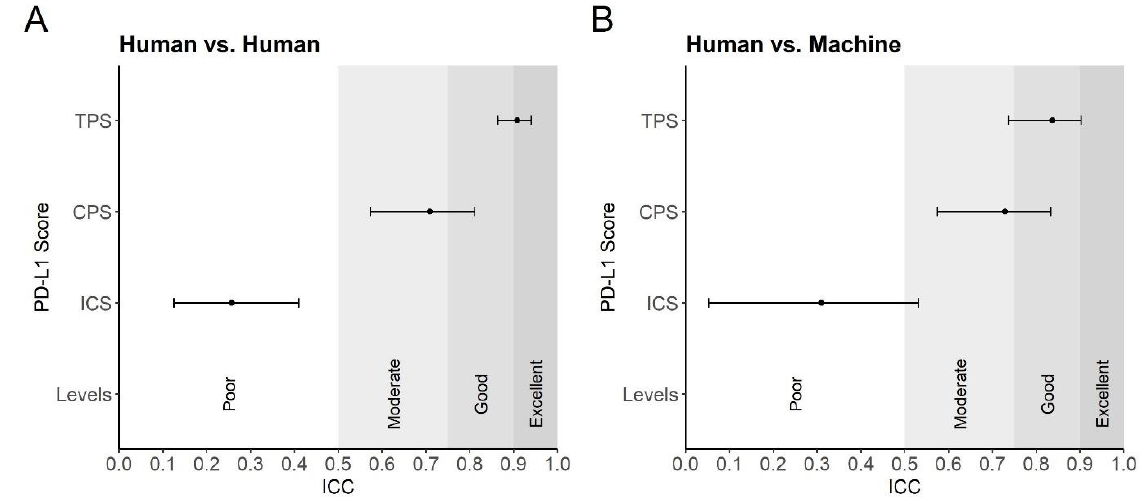
Figure 4. Intraclass correlation coefficient for PD-L1 scores. ( A , B ) The interclass correlation coefficients (ICCs) for TPS, CPS and ICS. The ICC is shown on the x -axis. An ICC of 0 to 0.5 is rated as poor, 0.5 to 0.75 is rated as moderate, 0.75 to 0.9 is rated as good, and 0.9 to 1.0 is rated as excellent. The y -axis shows the three PD-L1 scores (TPS, CPS, ICS) and “ Levels ” represents the interpretation levels of the ICC in words. The dots correspond to the estimated ICC and the horizontal bar represents the confidence interval; ( A ) PD-L1 scores compared between the four human investigators; ( B ) Automated PD-L1 scores were compared with manual PD-L1 scores.